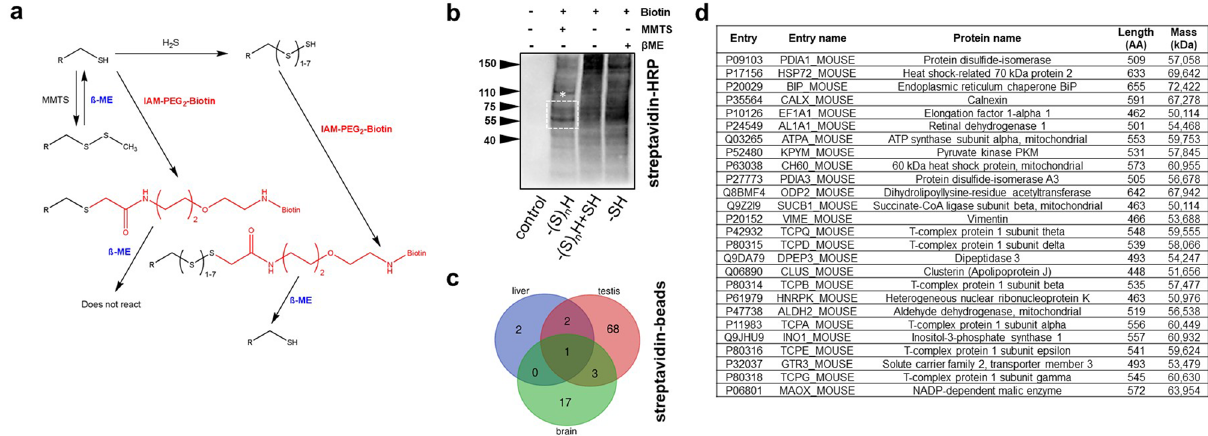
Figure 2. Persulfidation in mouse tissues with emphasis on testis. ( a ) Principle of selective detection of persulfidation (–(S) n H) using the thiol-selective binding ability of S-methyl methanethiosulfonate (MMTS) and the binding affinity of IAM-PEG-biotin to thiols (–SH). ( b ) β-Mercaptoethanol (β-ME), a reducing agent, was used to eliminate persulfide-biotin bonds and selectively detect free thiols. Bands in the size range 55–75 kDa (*) belonging to abundant proteins modified by –(S) n H. ( c ) Alternatively, selectively labelled –(S) n H with IAM- PEG-biotin was loaded on streptavidin-coated agarose beads. The eluted native proteins were digested and detected by nano-LC–MS. Liver, brain, and testicular tissues were processed via pulldown assays and nano-LC– MS detection, and persulfidated proteins were compared and expressed via Venn diagram. ( d ) Proteins of 55–75 kDa are presented in the